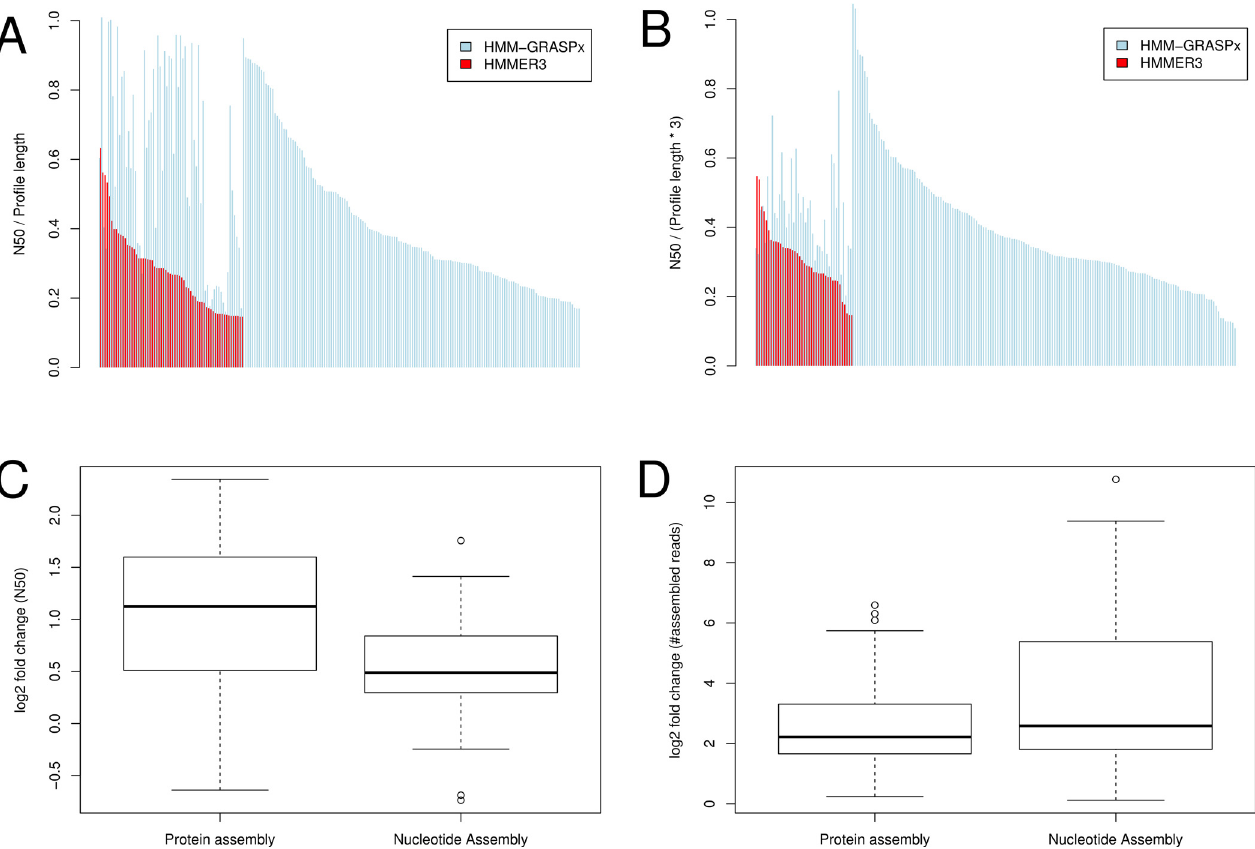
Fig 4. Targeted assembly of secondary metabolite synthesizing protein families from the in vitro human oral biofilm MT data set. Only the protein contigs longer than 60aa and nucleotide contigs longer than 180nt were considered. (A) Normalized N50 for protein assembly. (B) Normalized N50 for nucleotide assembly. For (A) and (B), red color indicates the performance of HMMER3 and blue color indicates HMM-GRASPx. The x-axes indicate assembly cases and were sorted based on the decreasing values of the HMMER3 performance and then the decreasing values of the HMM-GRASPx performance. Assembly cases without corresponding red bars indicate that no contig was assembled using HMMER3 predictions. (C) Log2 fold change for the N50 measures in assembly cases where contigs can be assembled using either HMMER3 or HMM-GRASPx prediction. (D) Log2 fold change for the number of assembled reads in assembly cases where contigs can be assembled using either HMMER3 or HMM-GRASPx prediction.